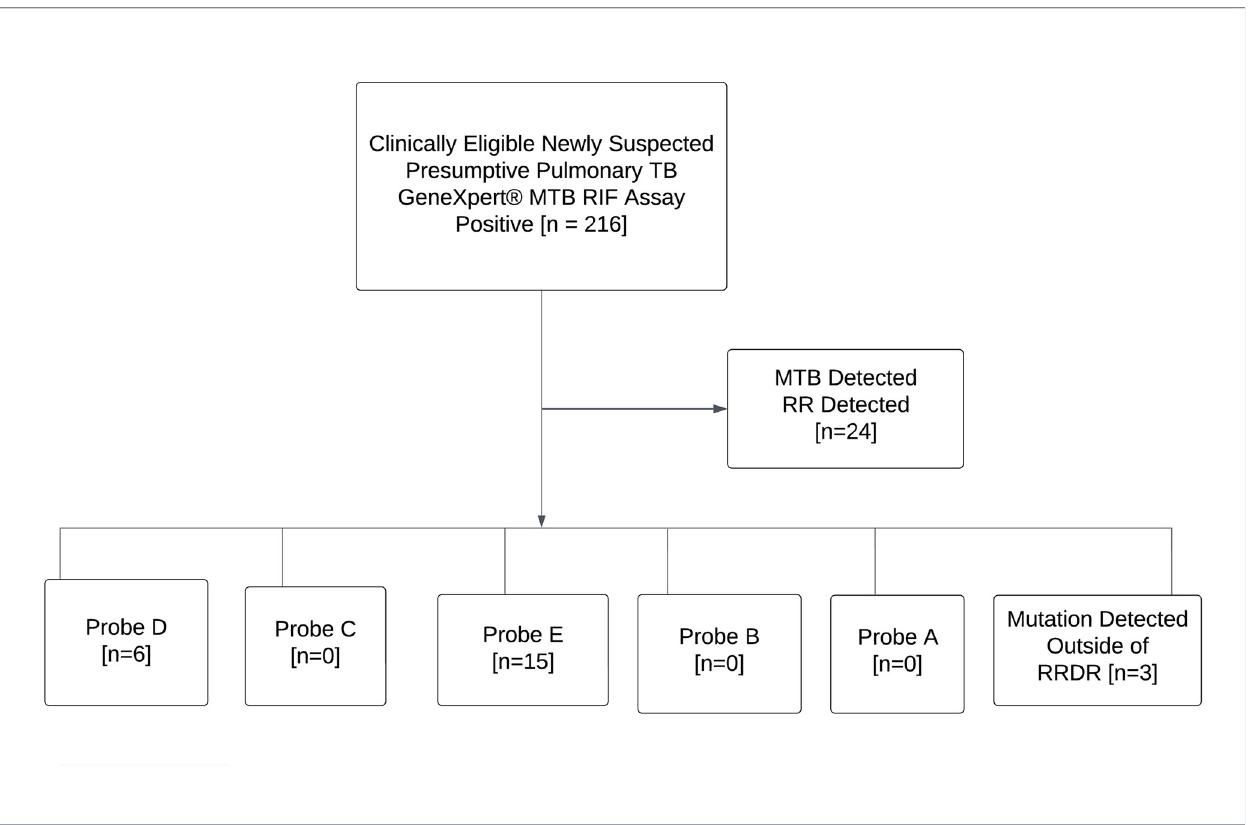
Fig 1. Flowchart showing RR TB detected in GeneXpert MTB/RIF assay.